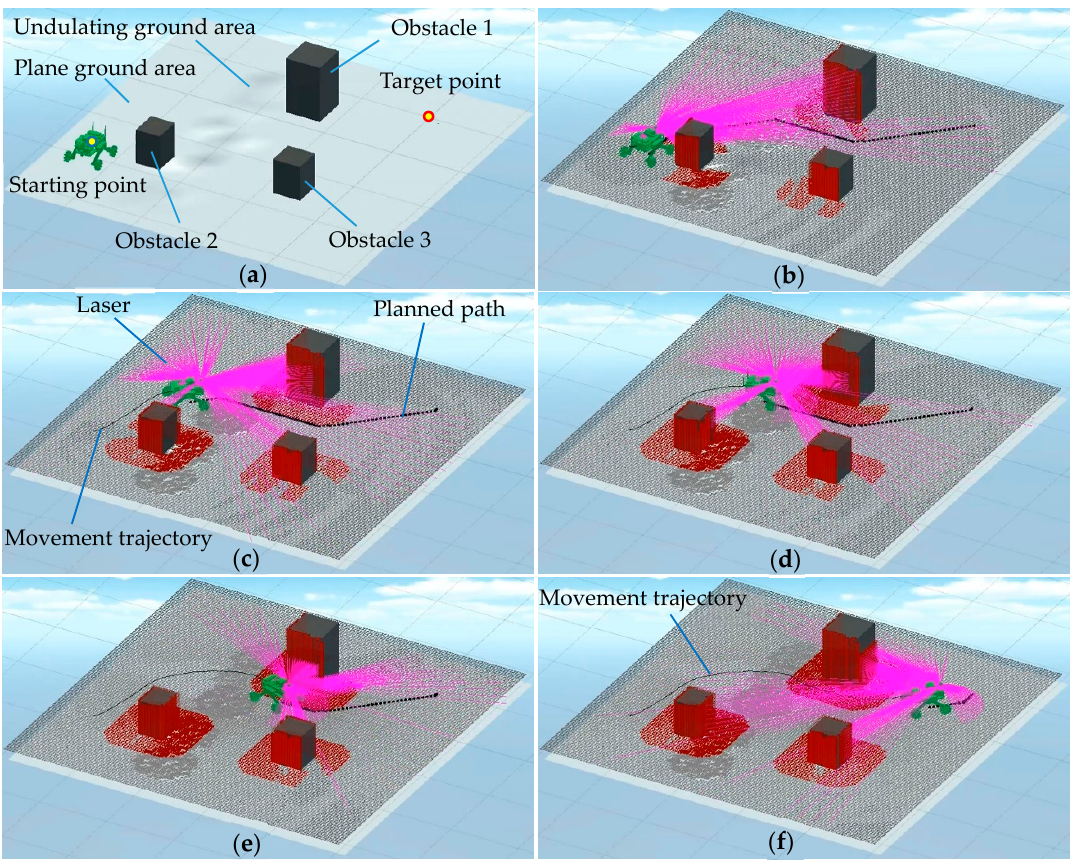
Figure 41. Navigation simulation of the robot in the environment created according to the physical environment in Figure 40: ( a ) the environment created according to the physical environment in Figure 40; ( b – f ) navigation simulation process of the robot.